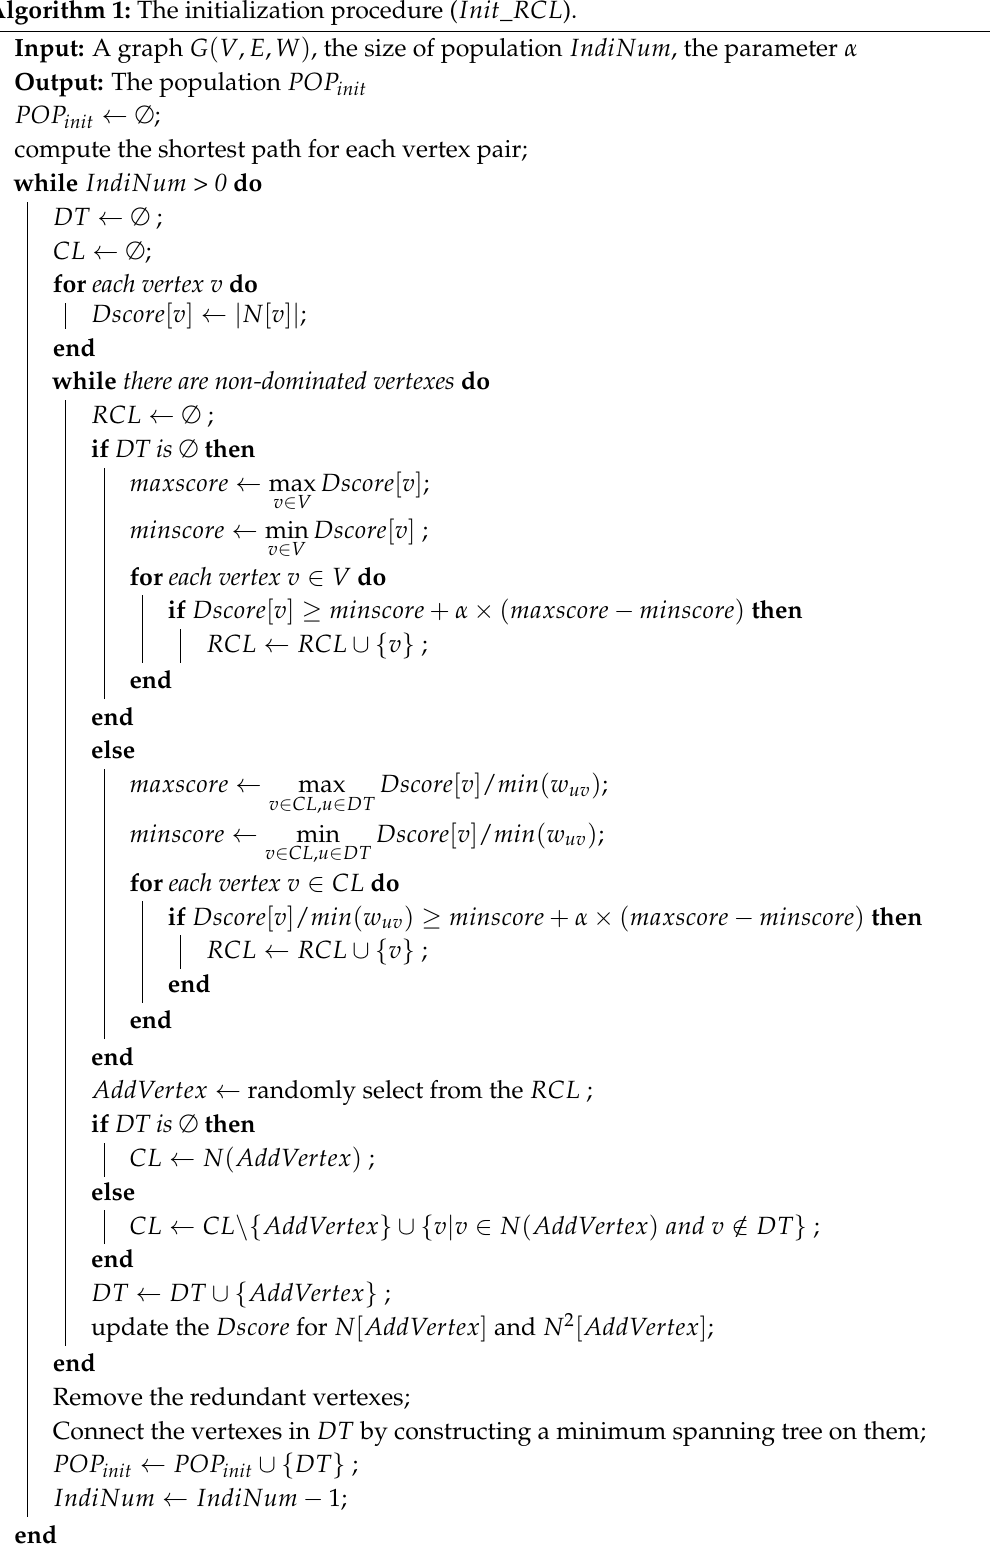
Algorithm 1: The initialization procedure ( Init _ RCL